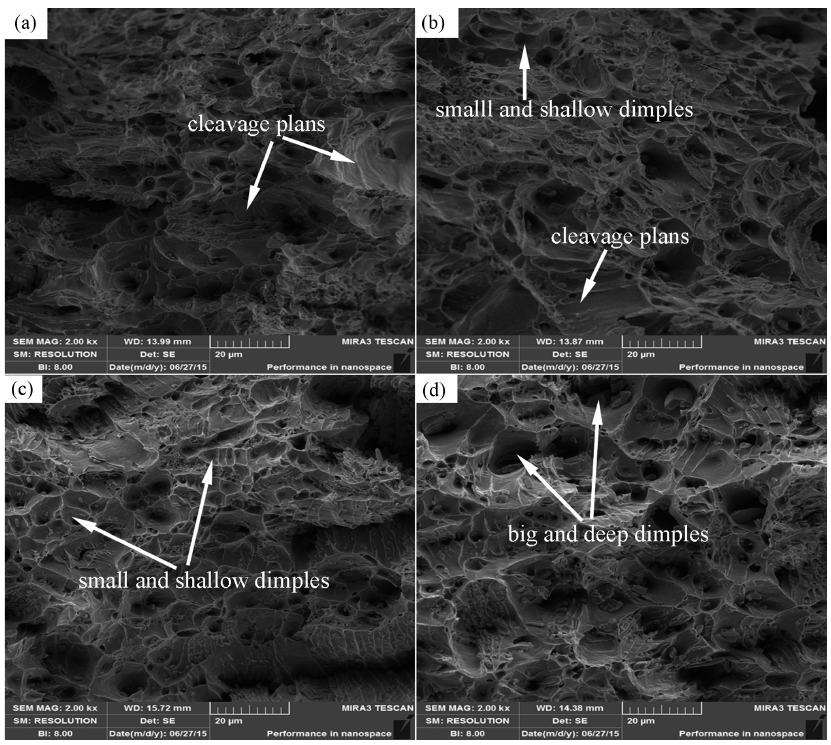
Figure 5: SEM fractrographs of Charpy impact samples with different Ce additions: (a) without Ce, (b) 0.0014% Ce, (c) 0.0020% Ce, (d) 0.0025%